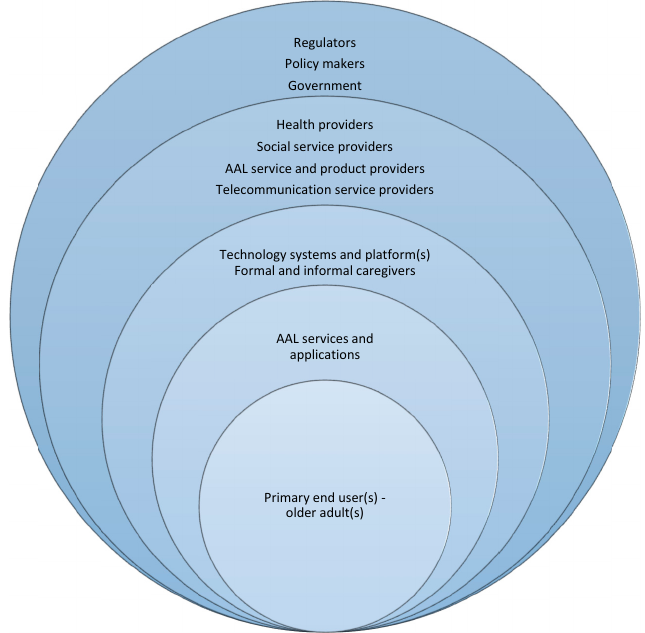
Figure 4. Socio-technical AAL ecosystem model.